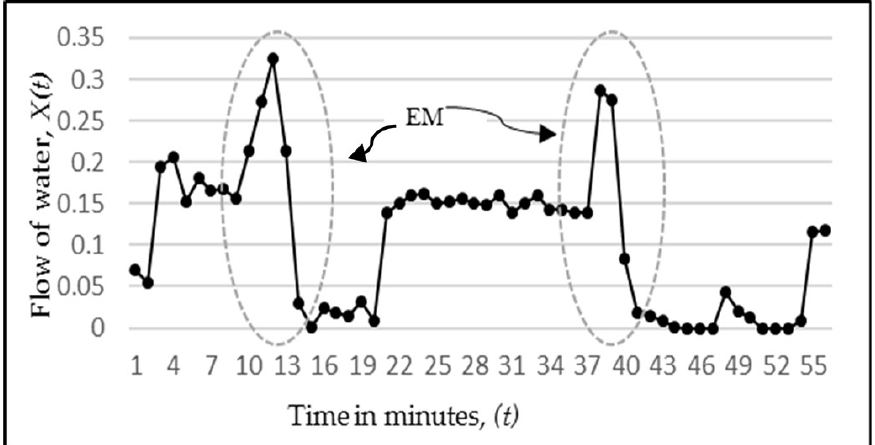
Figure 2. Normalized sample of flowmeter data having “Ending Marker”